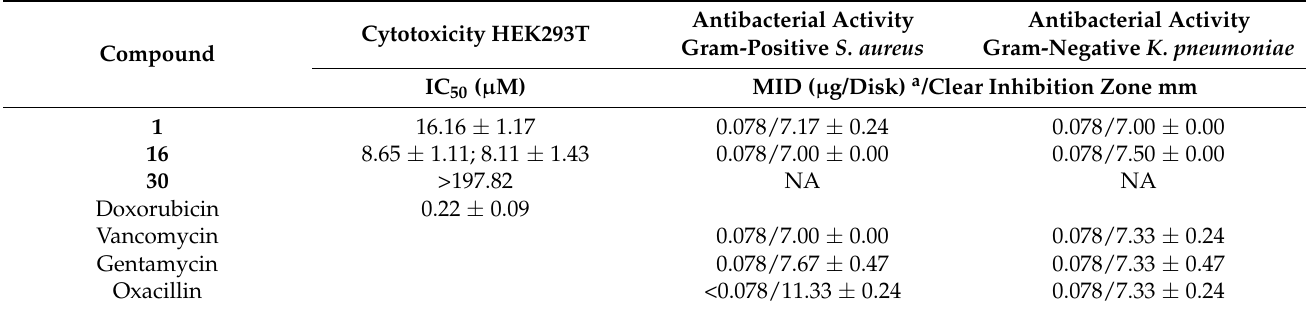
Table 2. Minimum inhibitory doses and inhibitory concentrations of compounds 1 , 16 , 30 .